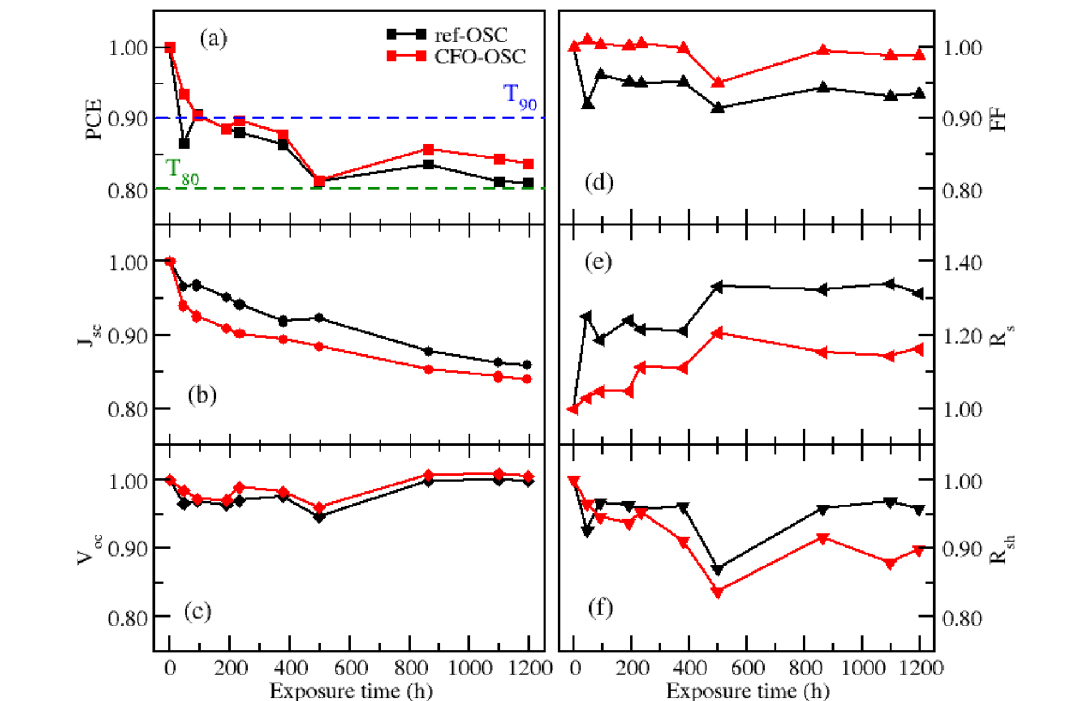
, (c) V , (d) FF, (e) R and (f) R of ref-OSC (black) and CFO-OSC (red) sc oc s sh